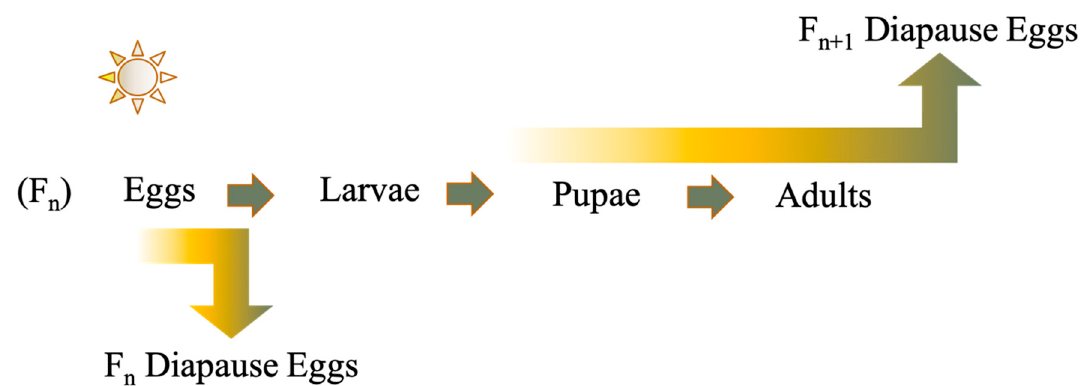
Figure 1. Two common photoperiodic diapause induction methods utilized by facultative embryonic diapause in the genus Aedes . Gradient arrows indicate the ability of the life-cycle stage to sense environmental cues needed to enter diapause either in the F n generation or F n+1 generation.